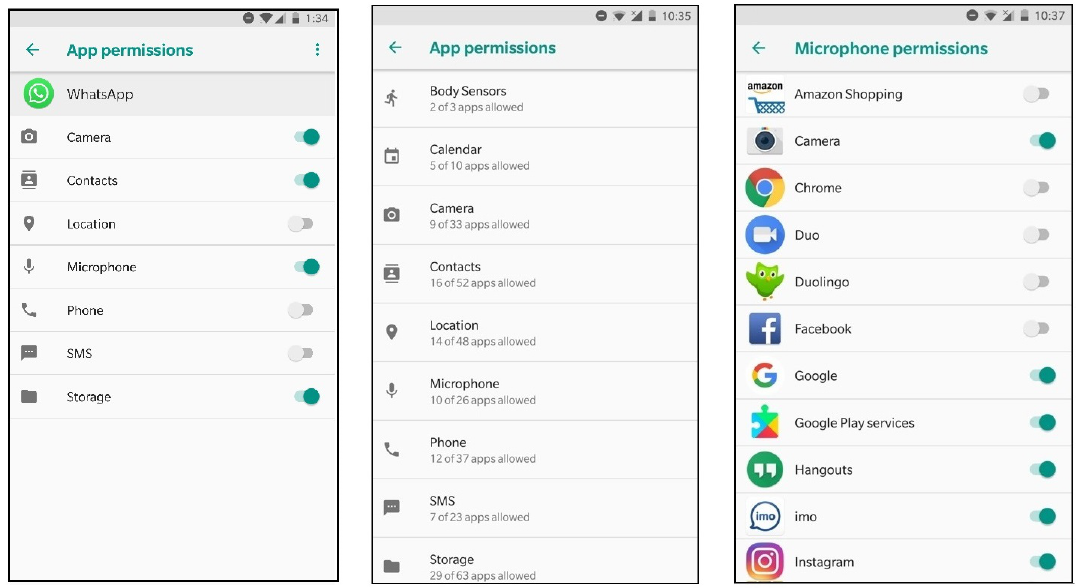
Figure 3. Android permission models; left : per app, middle and right : per